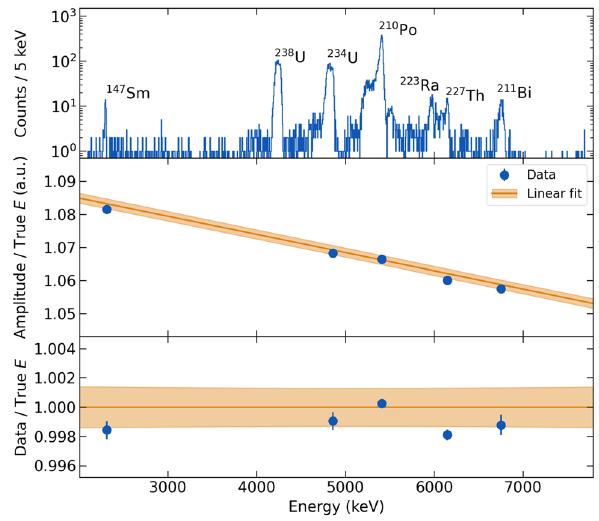
Fig. 3 Energy calibrations of the α -peaks in C4. The top panel shows the energy spectrum; the middle panel shows the ratio of the true energy to the phonon signal amplitude and its linear fit; the ratio of the recon- structed energy to its nominal value is shown in